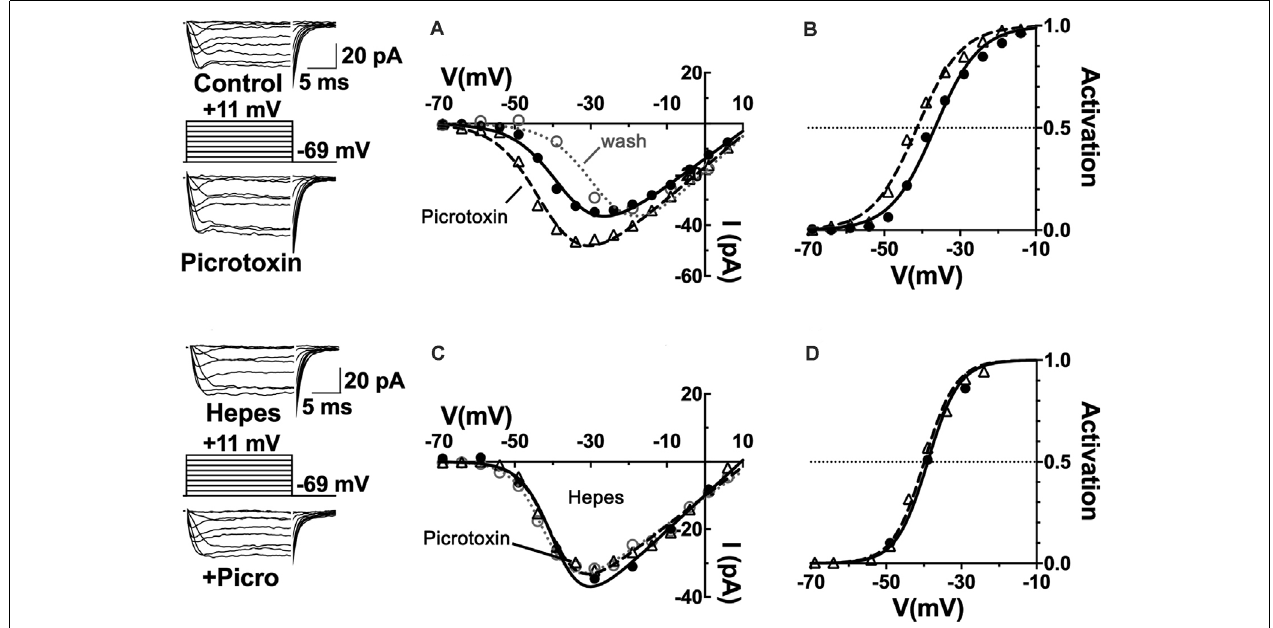
FIGURE 4 | Ca V channels in mammalian cone photoreceptors are maintained in a pH-mediated, tonically inhibited state by GABA receptor activation. (A) The GABA A R antagonist picrotoxin increased calcium current amplitude in cones, maintained in mesopic conditions. Sample current traces and I–V relations of a rat cone before (solid line, filled circles), during (dashed line, triangles), and after (dotted line, open circles) application of 100 µ M picrotoxin to the retinal slice. (B) The Ca V channel activation curve for the cell underwent a leftward shift in the half-maximal activation voltage in picrotoxin (midpoint = − 41 mV) vs. control (midpoint = − 37 mV). (C) Same experimental protocol as above applied while clamping superfusate pH to 7.4 with 10 mM Hepes. I–V relation in Hepes alone is shown (solid line, circles) and then with picrotoxin (dashed line, triangles). Washout superimposes (dotted line, open circles). (D) Hepes eliminated the effect of picrotoxin on Ca V channel activation (midpoint = − 39 mV). Figure modified from Grove et al.